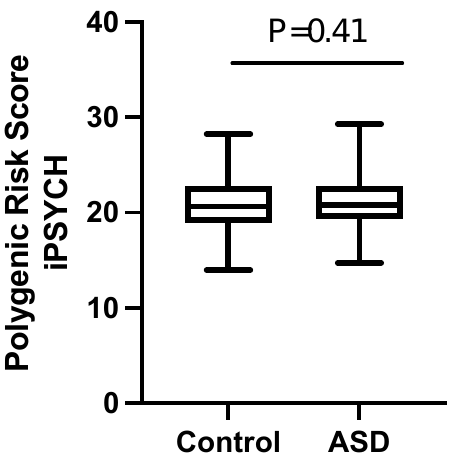
Figure 3. Analysis of polygenic risk scores (PRS). Assessment of PRS defined by SNPs with p < 1 × 10 − 6 reported by Grove el al. (iPSYCH) [23] in our cohort. Values are presented as box and whiskers plots showing the interquartile range (boxes), median (horizontal line), the minimum and maximum values (whiskers).